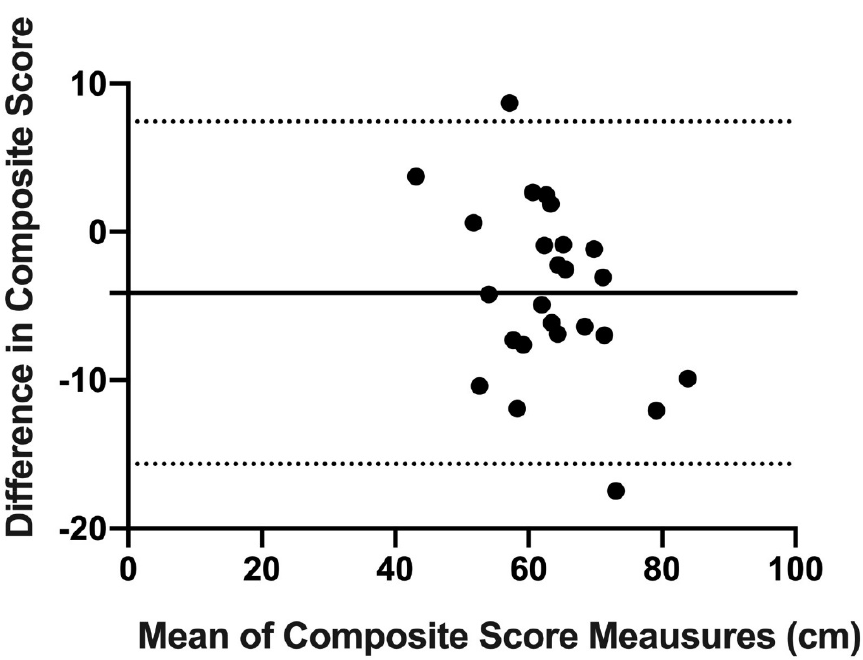
Figure 12. Bland–Altman left inferolateral.